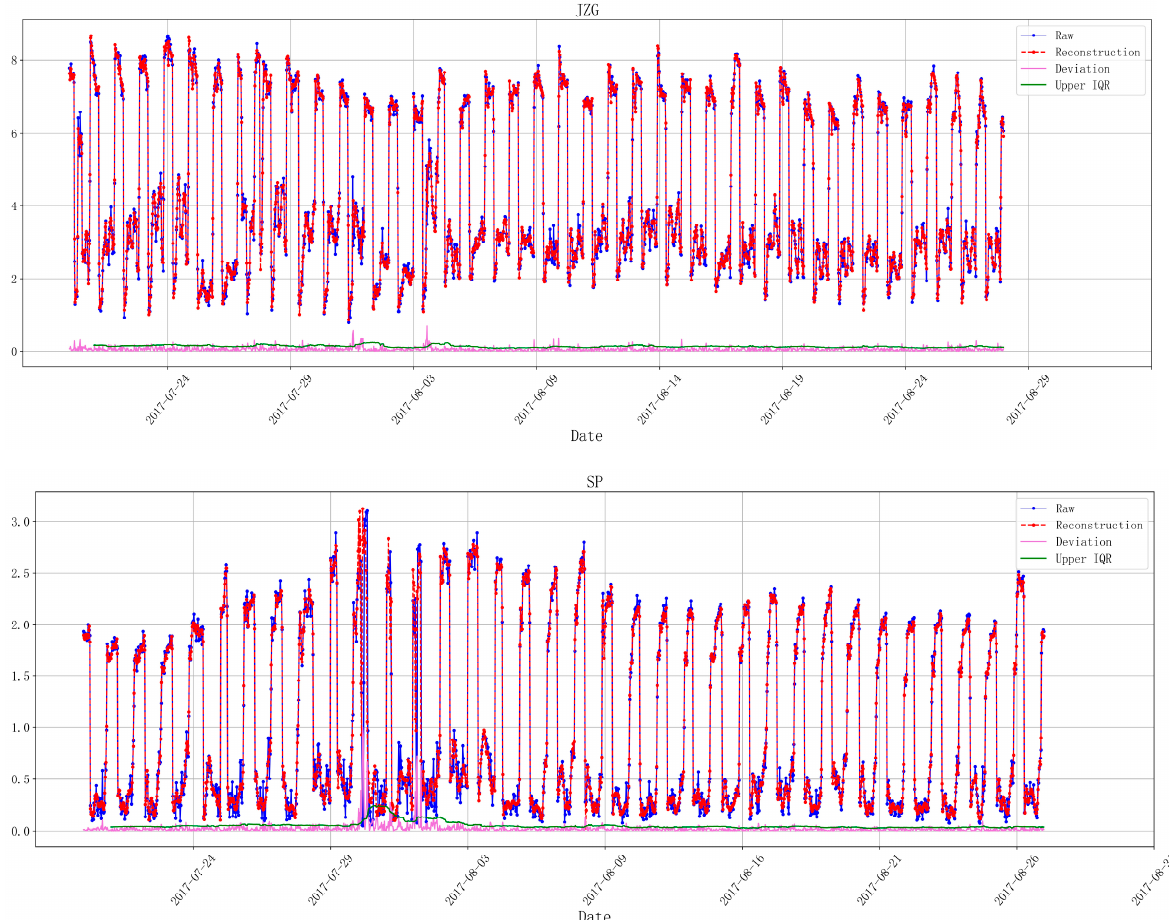
Figure 8. Electromagnetic disturbance, fitting vector and reconstruction deviation in JZG and SP